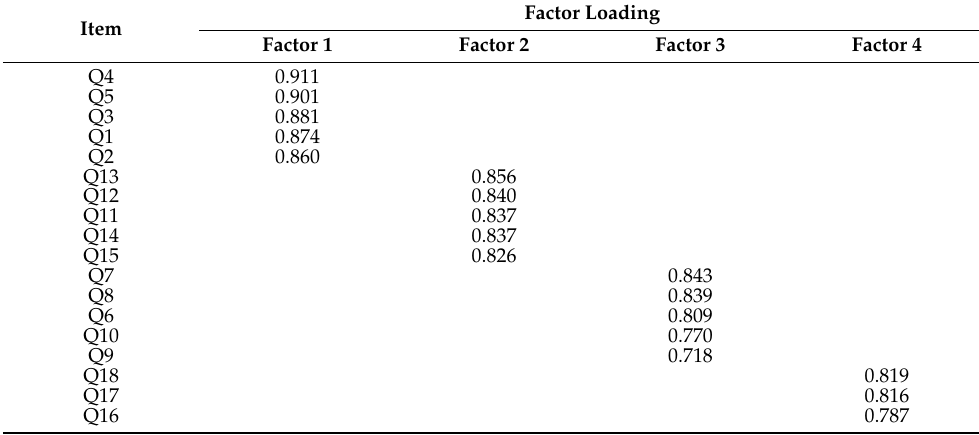
Table 3. Results of the EFA and factor loading for the MCPAQ-INIT ( n =